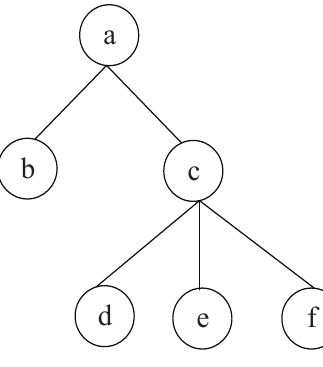
Figure 1. An example